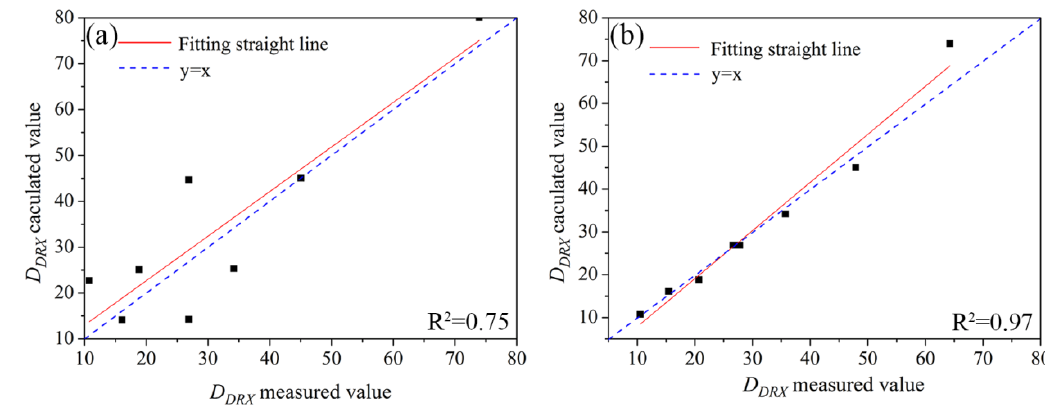
Figure 9. A comparison of measured value and calculated value of recrystallized grain size: ( a ) model represented by Z parameters, and ( b ) model expressed by strain rate and deformation temperature.